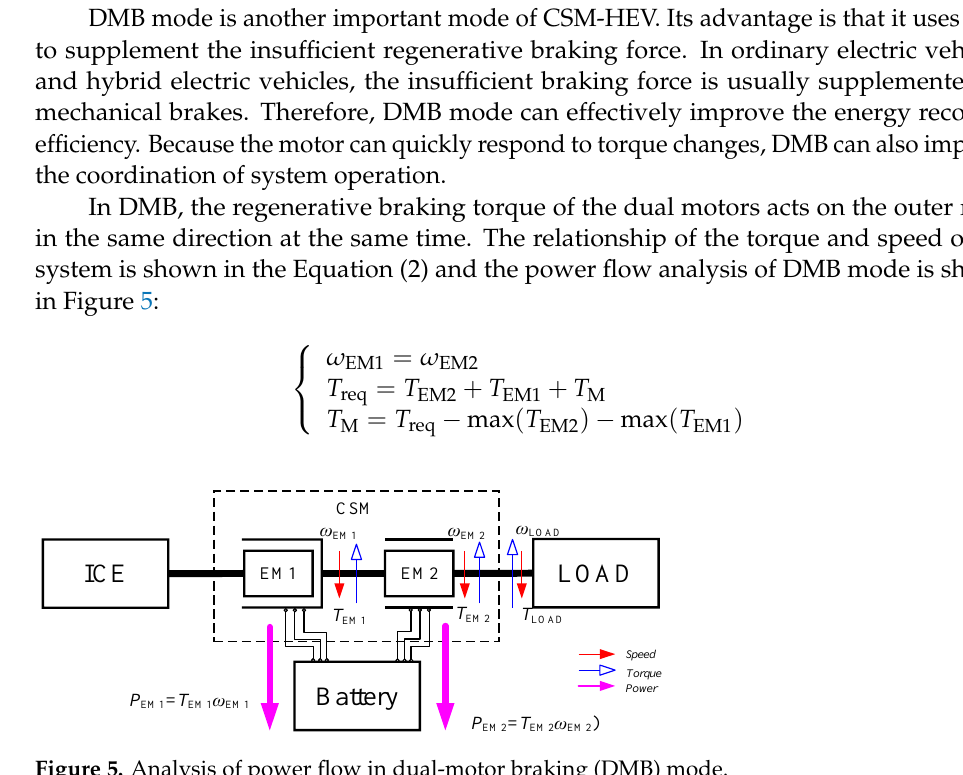
Figure 5. Analysis of power flow in dual-motor braking (DMB) mode.